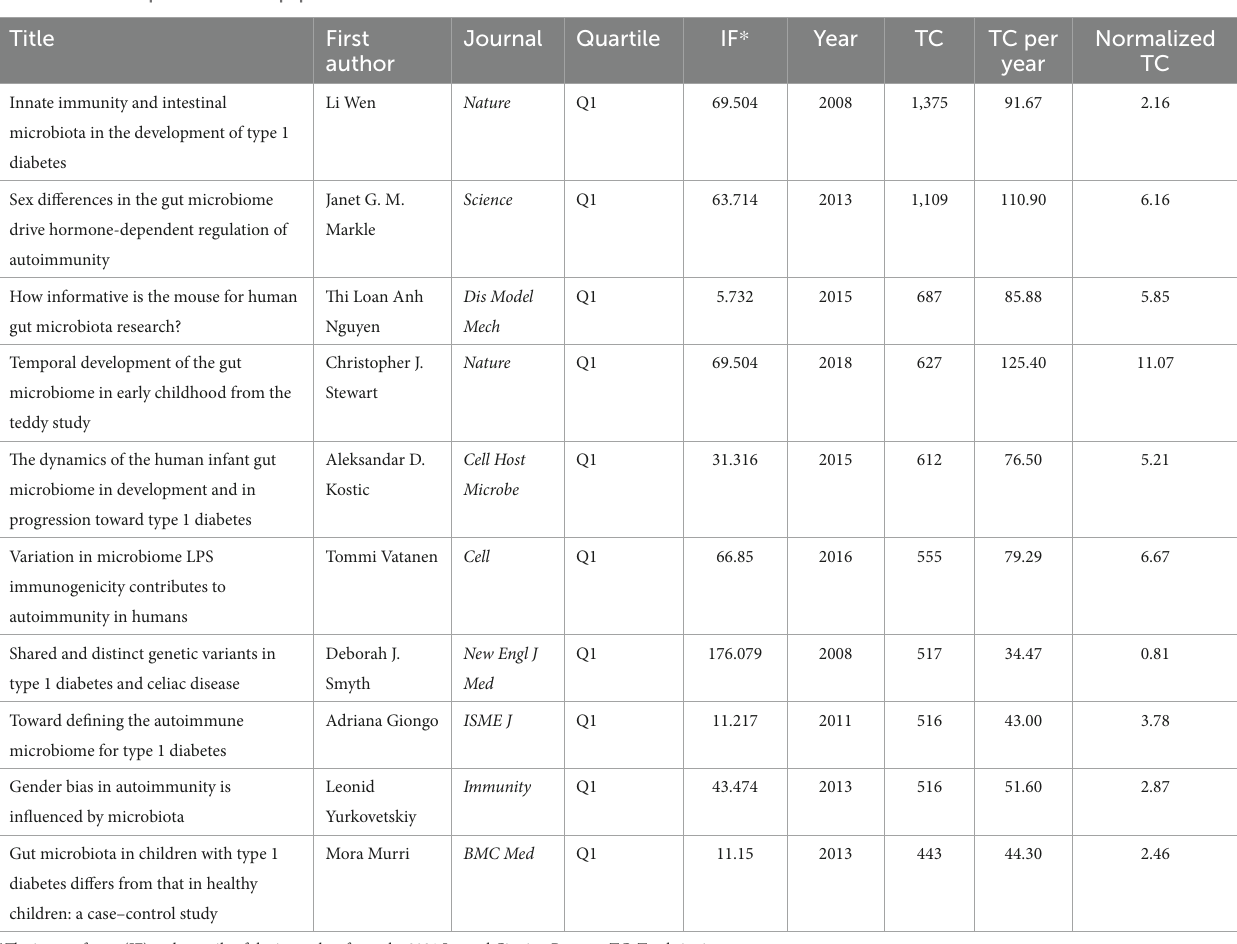
TABLE 4 Global top 10 most cited papers.